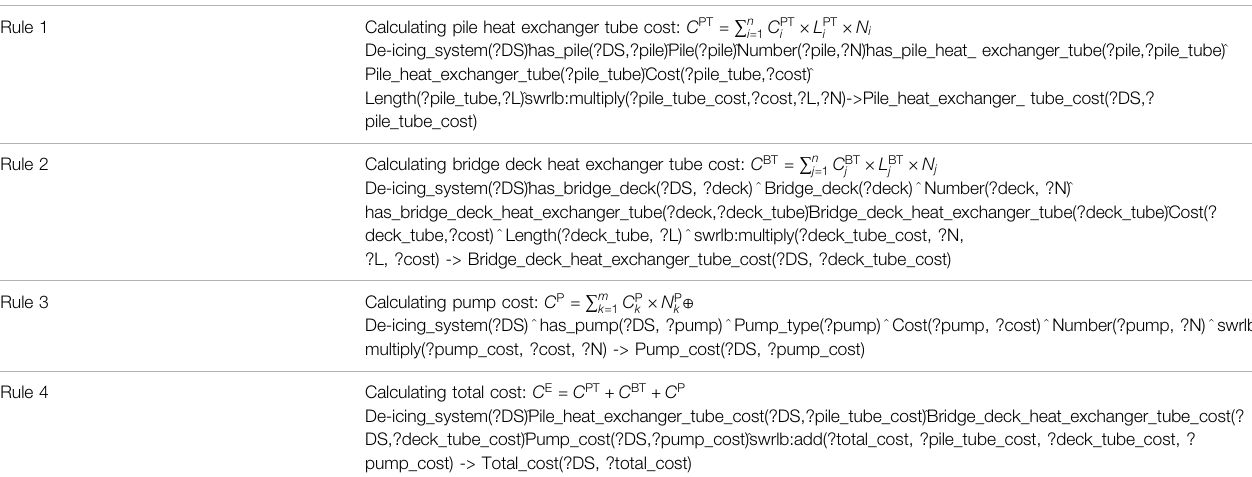
TABLE 4 | SWRL rules to calculate the total cost.